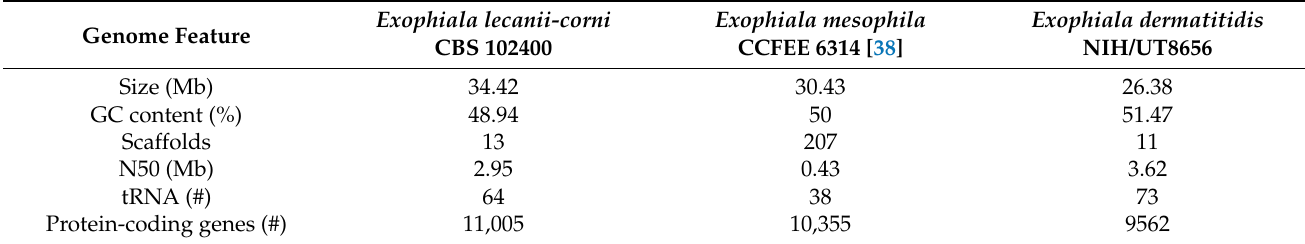
Table 1. General genome characteristics and assembly features of E. lecanii-corni CSB 102400 compared to E. mesophila CCFEE 6314 [38] and E. dermatitidis NIH/UT8656.